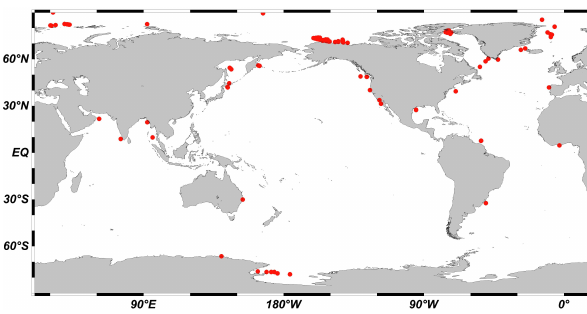
Fig. 12. Geographical distribution of the 277 samples located within 300km of a major coastline and with a SIT residual error greater than ± 50µmolkg − 1 for C T and/or A T